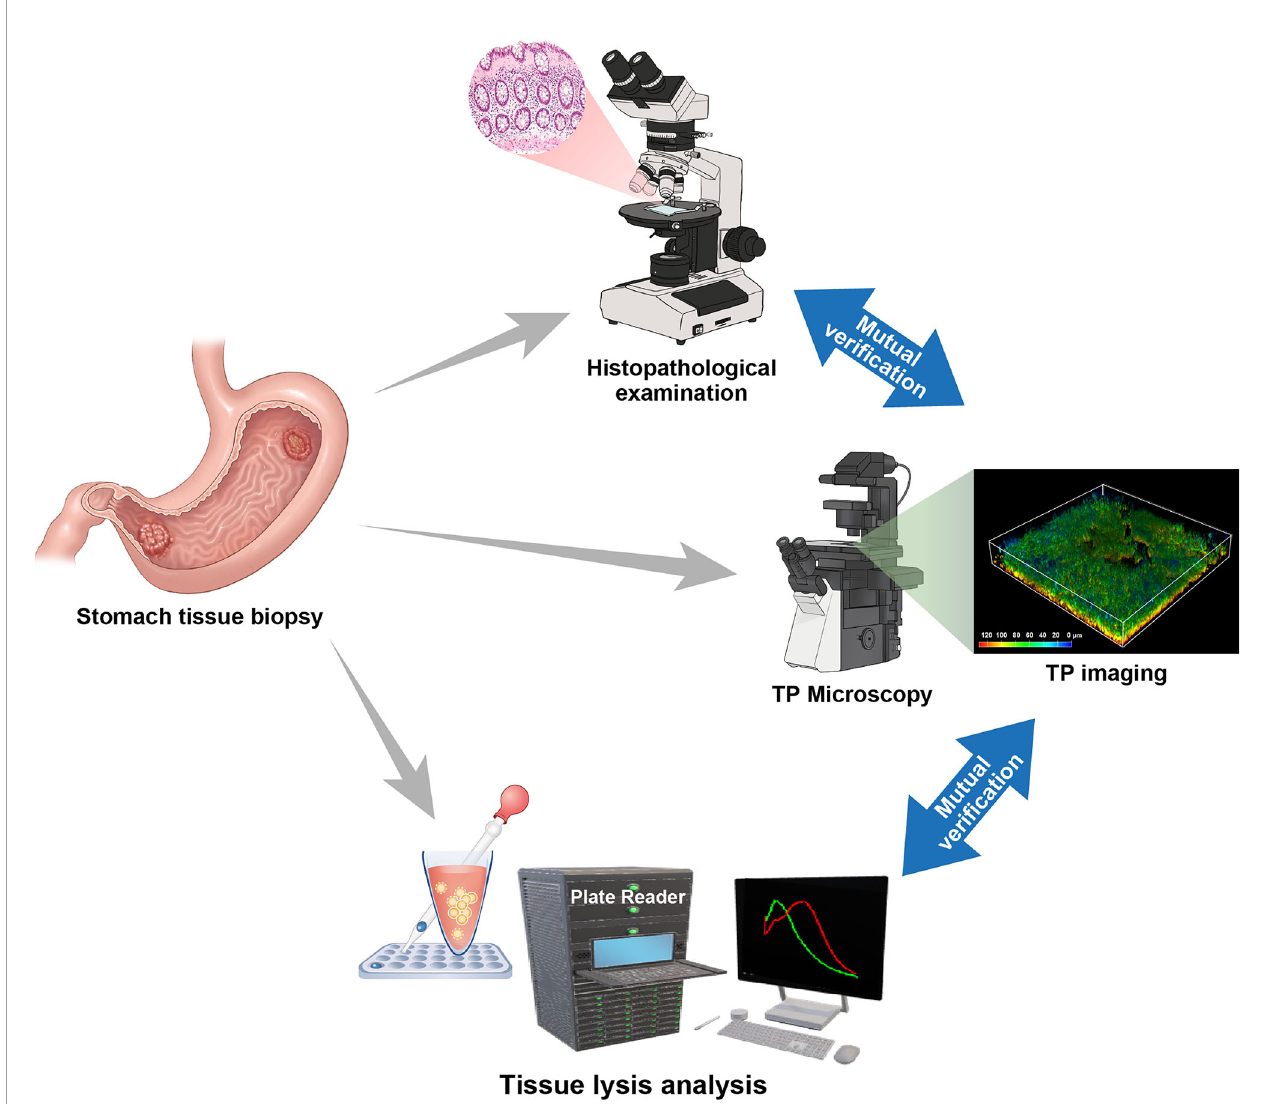
FIGURE 4 | Two-photon fl uorescence imaging through the acquisition of stomach tissue specimens using a mutual veri fi cation system including histological examination and tissue lysis fl uorescence analysis for an accurate